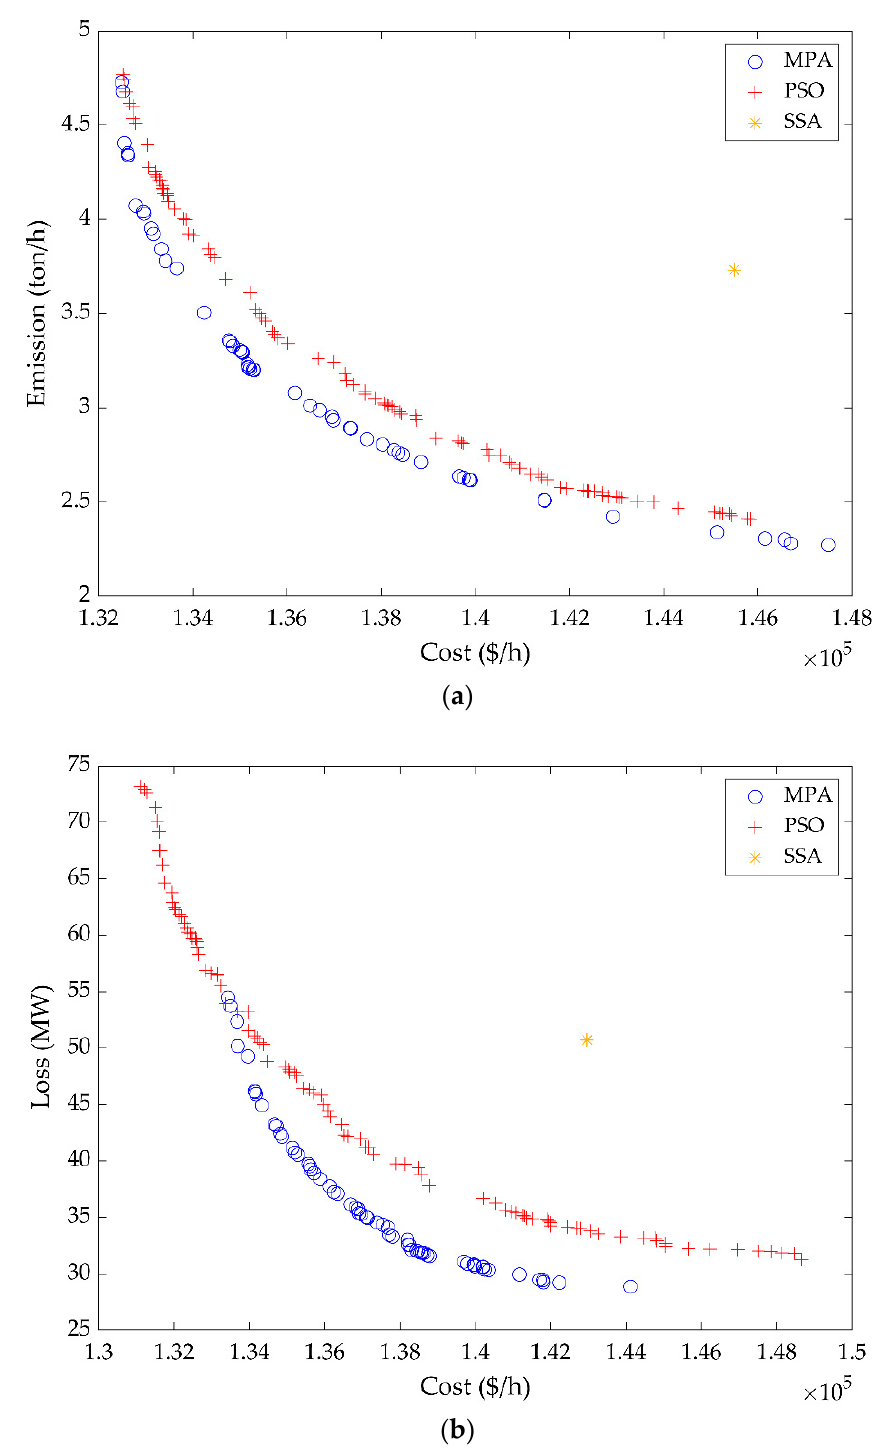
Figure 6. Two-dimensional Pareto fronts for: ( a ) case 15; ( b ) case 16.